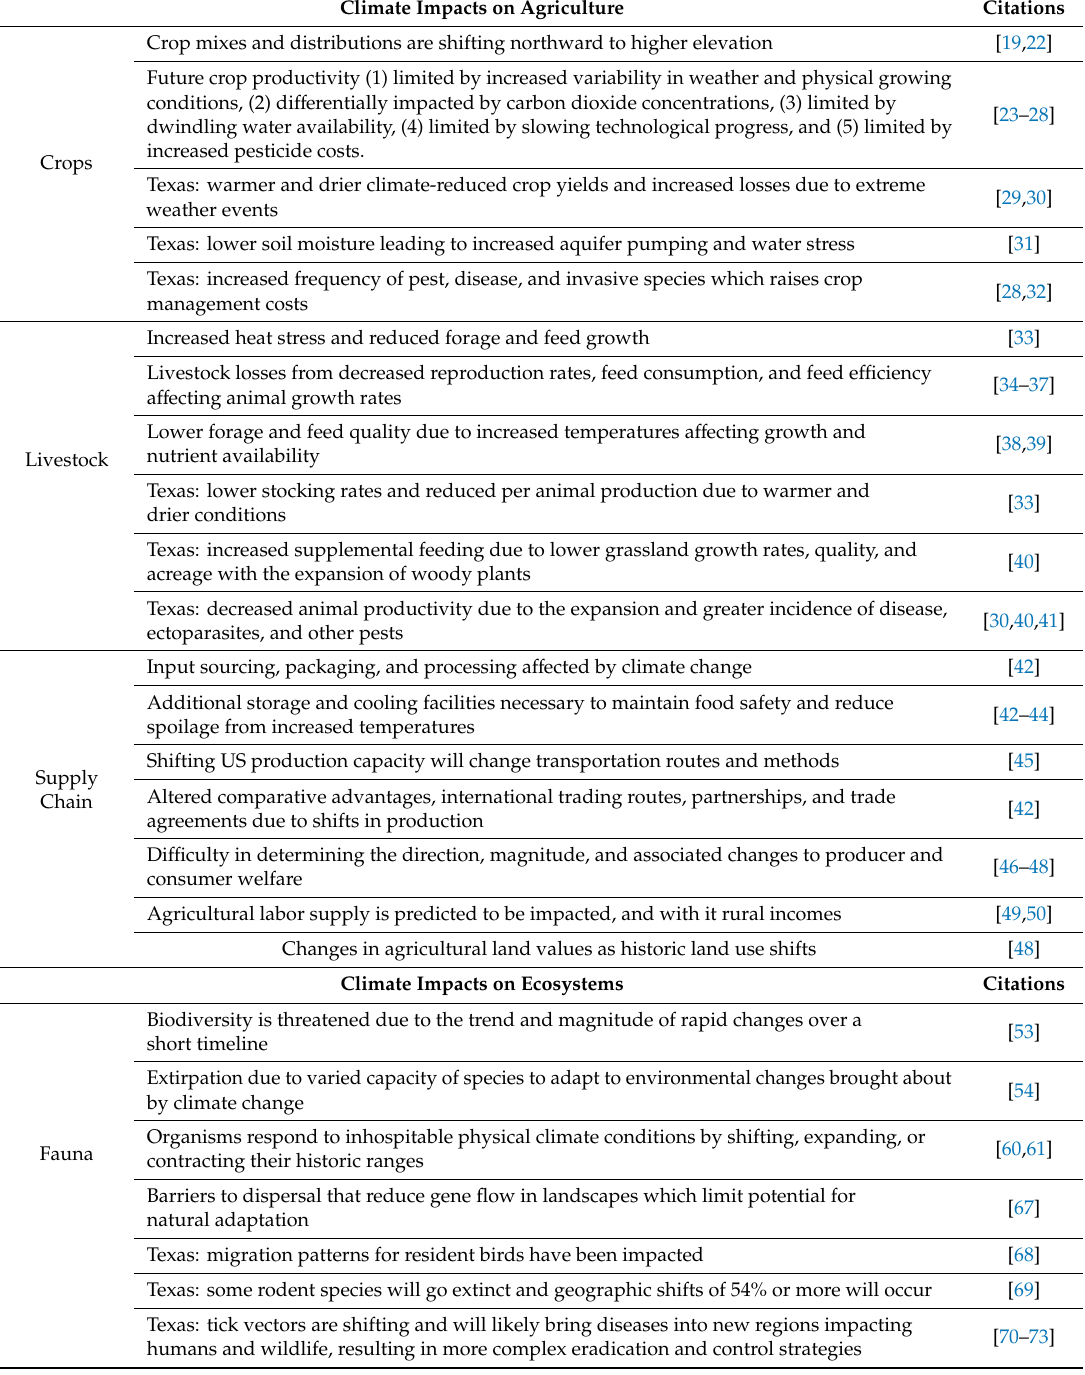
Table 1. A summary of climate change impacts on agriculture and